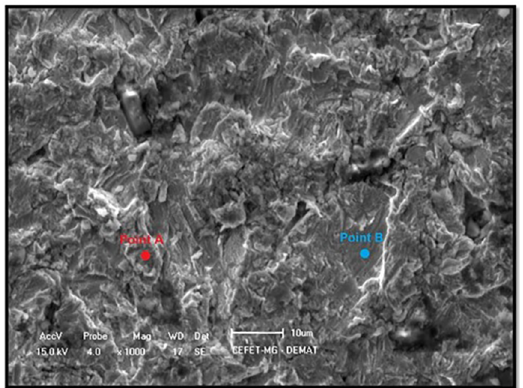
Figure 3. Microstructure of the sample 1 coated with black chromium.